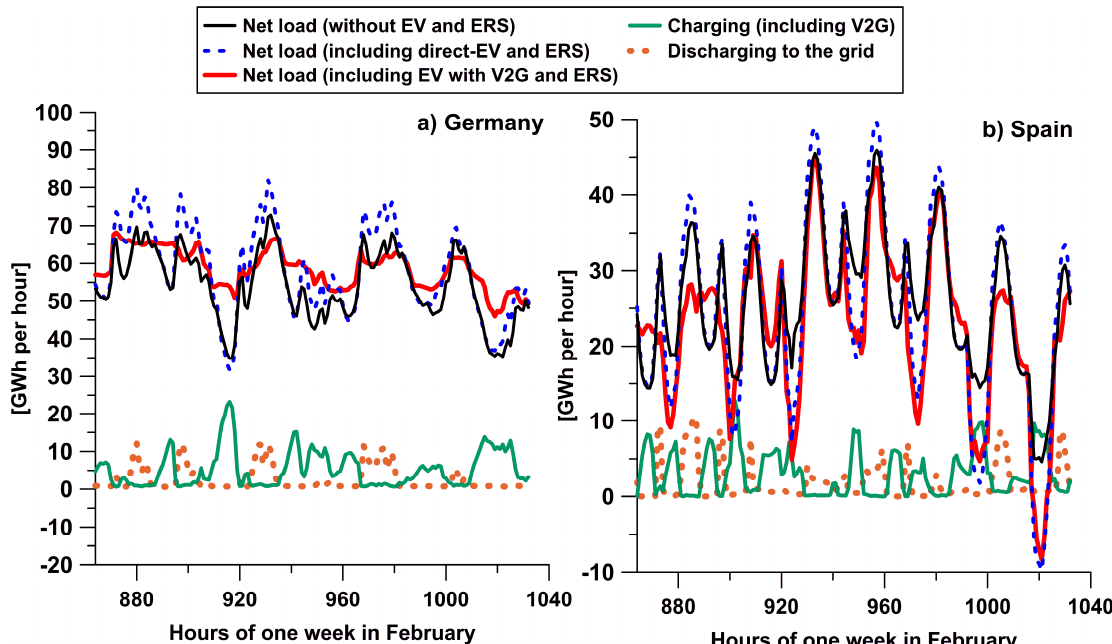
Figure 6. The net load without EVs and ERS (i.e., the load minus useful solar and wind electricity generation), the net load including direct charging of EVs and ERS for trucks and buses, the net load including EVs with V2G and ERS, and the load from charging and discharging to the grid are shown for 1 week in February for ( a ) Germany and ( b ) Spain.